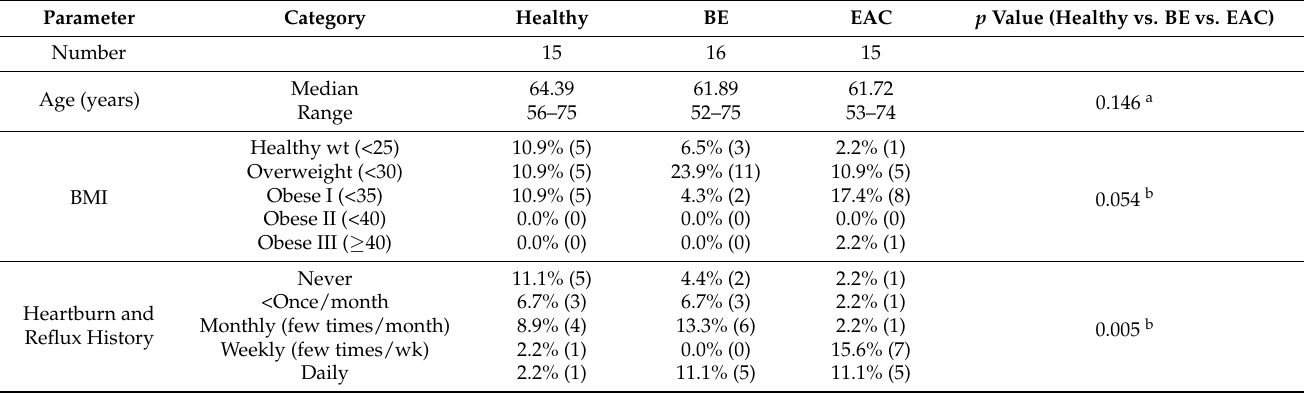
Table 1. Characteristics of the selected